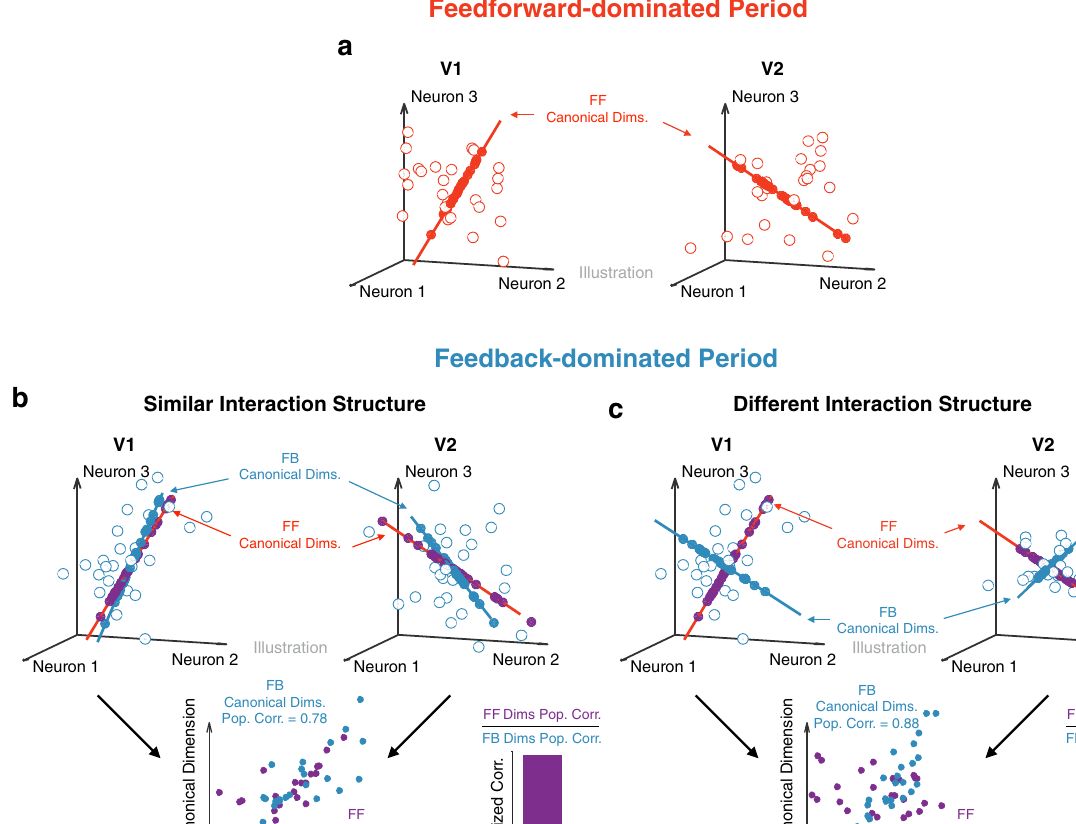
FF Canonical Dims. Pop. Corr. = 0.13